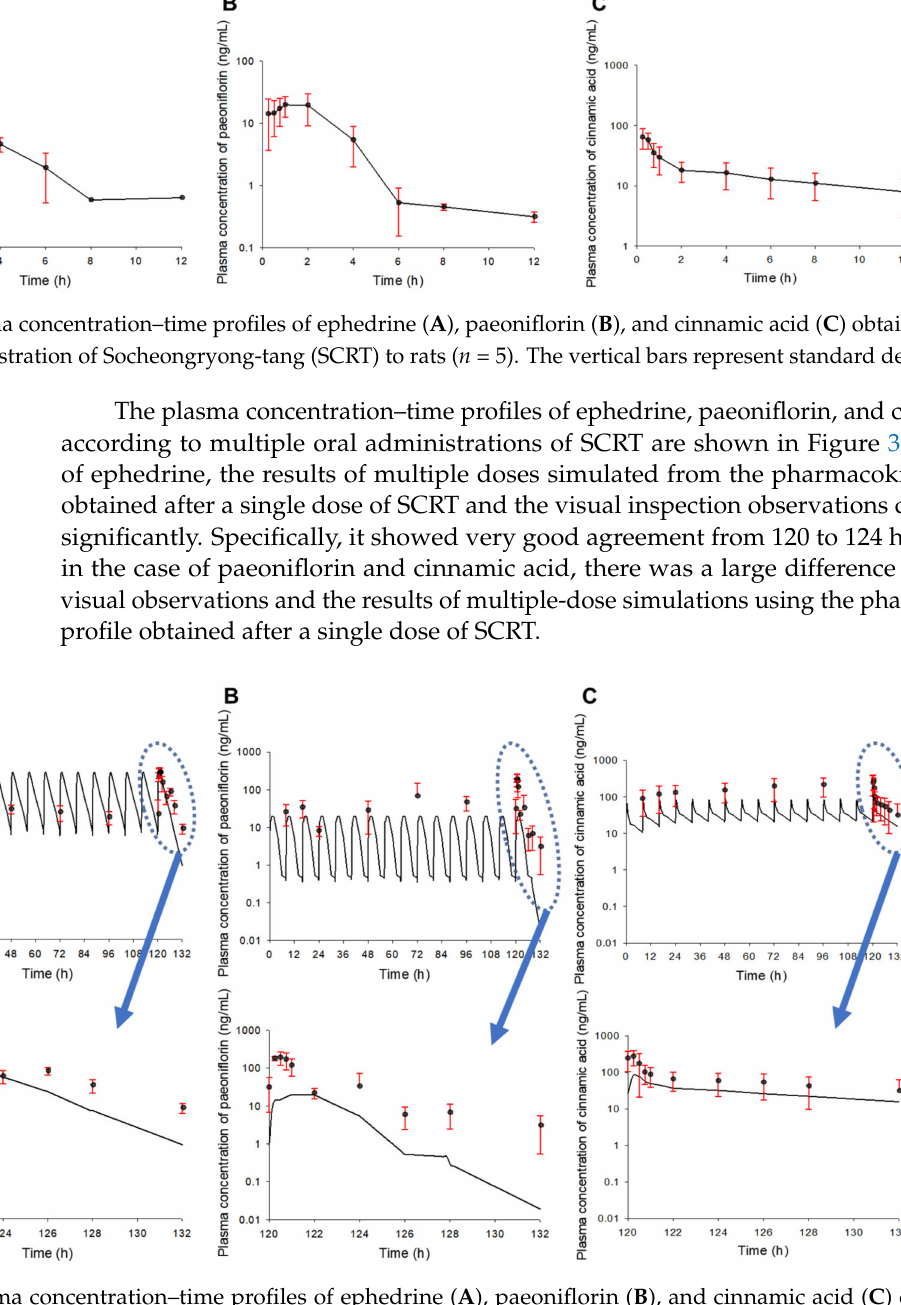
Figure 3. Mean plasma concentration–time profiles of ephedrine ( A ), paeoniflorin ( B ), and cinnamic acid ( C ) obtained after multiple oral administrations (from 0 to 120 h at 8 h intervals) of SCRT to rats ( n = 5). The solid-line graphs are the simulation (mean value) graphs of multiple doses based on the single-dose (mean) data of SCRT. The black dots represent experimental observation values. The vertical bars represent standard